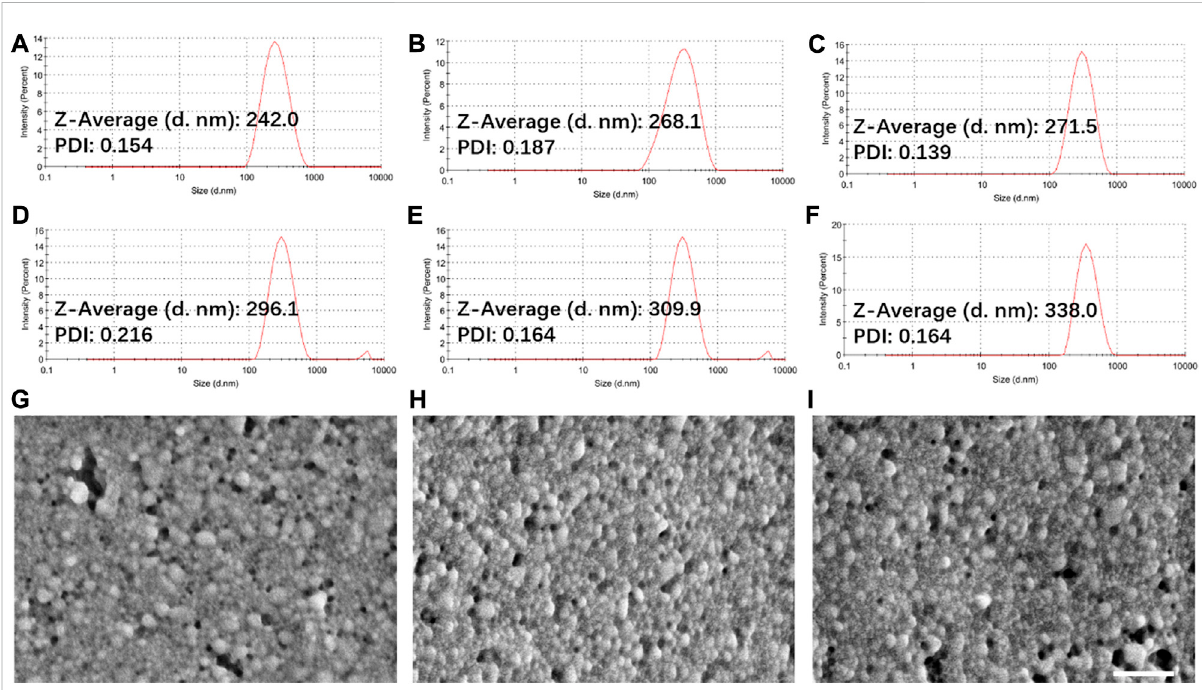
FIGURE 1 Particle size and PDI of CLA NPs (A) , CCA NPs (B) , CLC NPs (C) , DOX-CLA NPs (D) , DOX-CCA NPs (E) and DOX-CLC NPs (F) measured by DLS; SEM images of DOX-CLA NPs (G) , DOX-CCA NPs (H) , and DOX-CLC NPs (I) ; Scale bar = 500